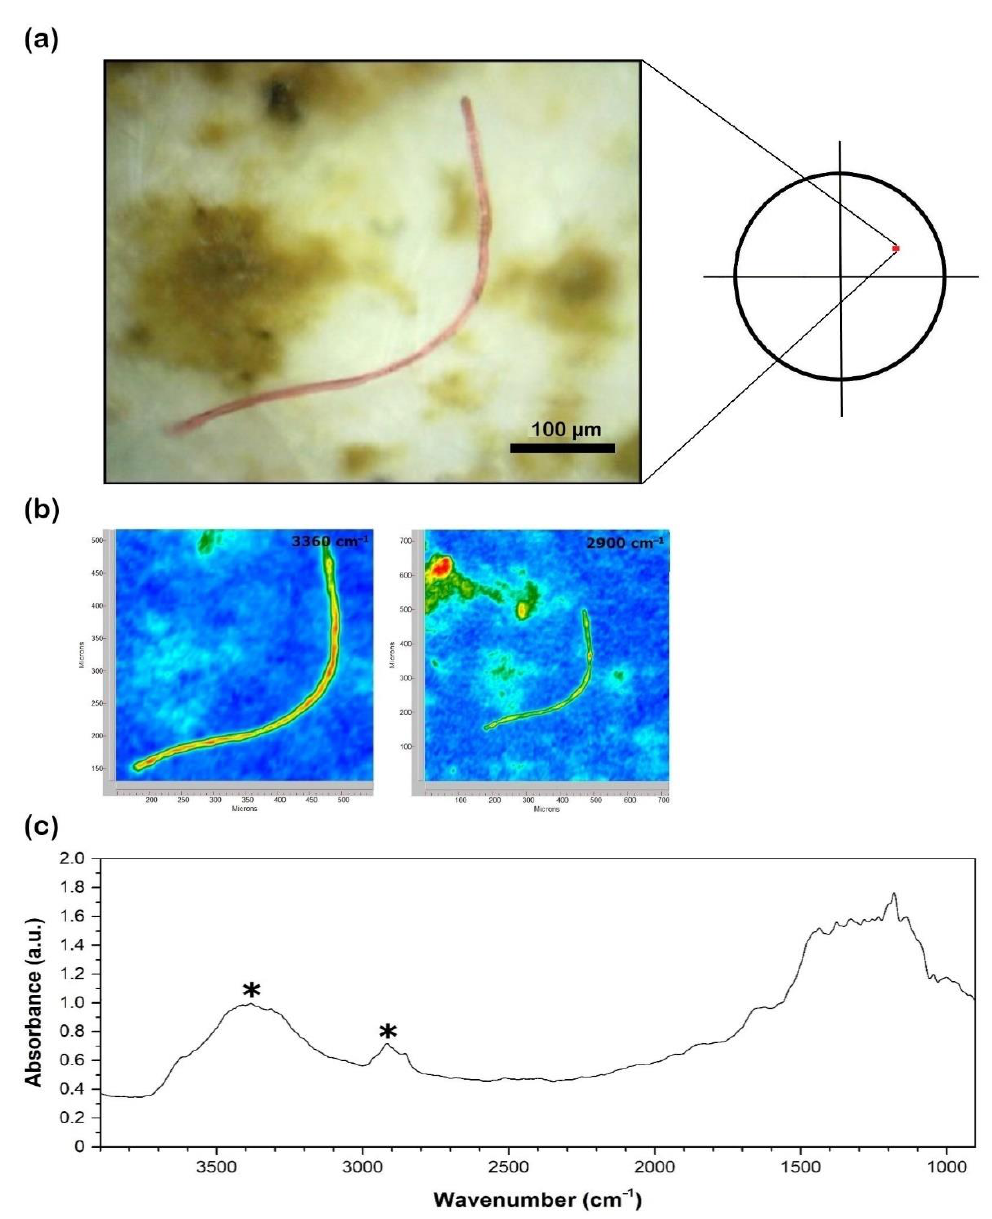
Figure 4. ( a ) Visible light map of the filter substrate with a cellulosic microfiber lying on it; ( b ) 2D FTIR imaging maps where the intensity of the following bands was mapped: 3500–3100 (O–H stretch, hydroxyl groups of the anhydroglucose unit), 3000–2900 (stretch of methyl and methylene C–H bonds). The chromatic scale of each map qualitatively shows the absorbance intensity, as follows: blue, green, yellow, red. Maps have dimensions of 700 × 700 μm 2 ; ( c ) FTIR reflectance spectra of the cellulosic microfiber and diagnostic bands ( * symbol), assigned according to reference standards reported in [50].